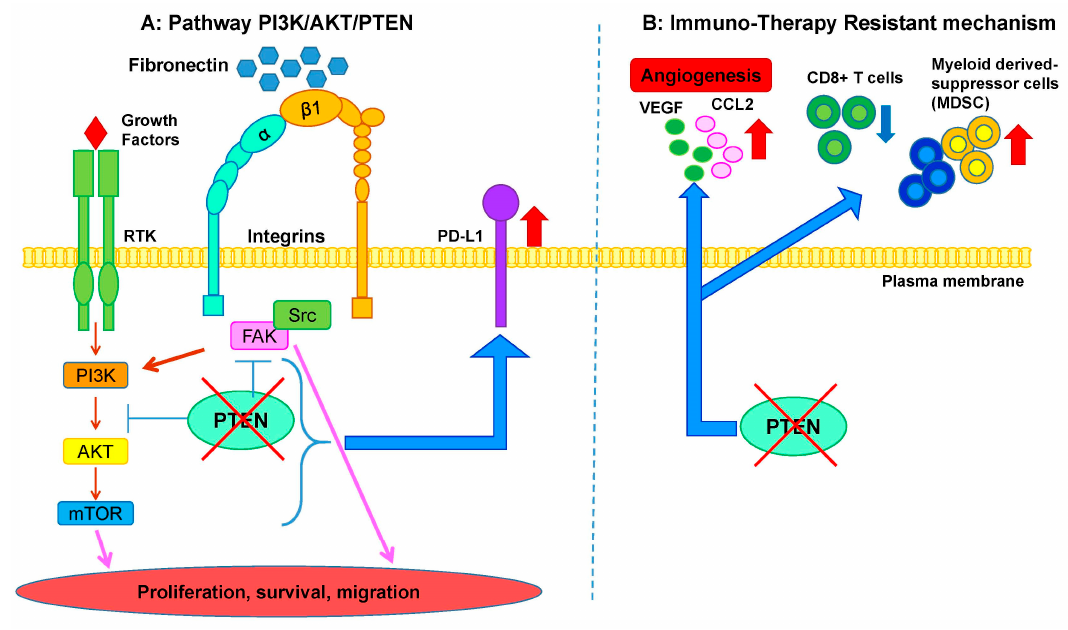
Figure 1. PTEN pathway and its implication in immuno-therapy resistance. ( A ) Overview of the / AKT / PTEN pathway. ( B ) Scheme of potential immuno-therapy resistance PI3K/AKT/PTEN pathway. ( B ) Scheme of potential immuno-therapy resistance mechanisms. PI3K